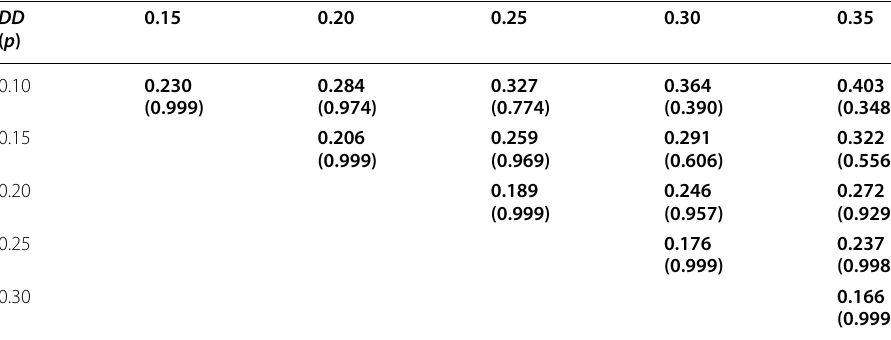
Table 6 Robustness results in S&P